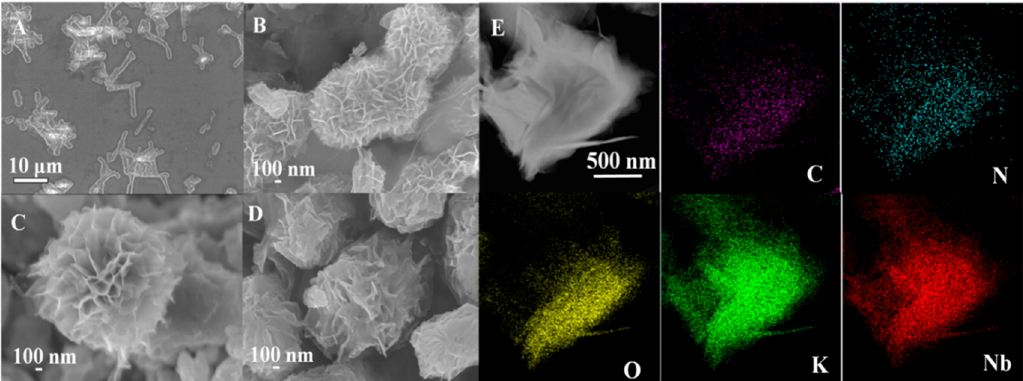
Figure 5. Scanning electron microscopy (SEM) images for: ( A ) Nb 6 ; ( B ) Nb 6 / PPy-RGO-0.125; ( C ) Nb 6 / PPy-RGO-0.25; ( D ) Nb 6 / PPy-RGO-0.375. ( E ) Transmission electron microscopy (TEM) images and the element maps of Nb 6 /PPy-RGO-0.25.